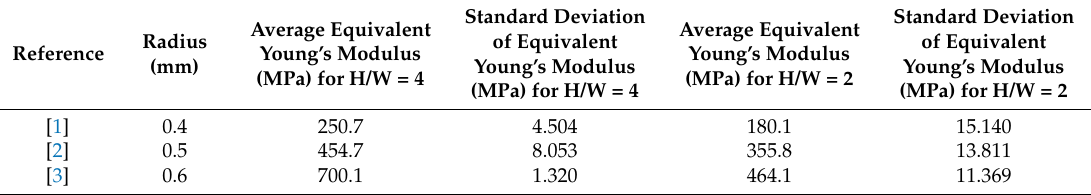
Table 4. Young’s modulus equivalent to each structure of the octet-truss, given by the compression